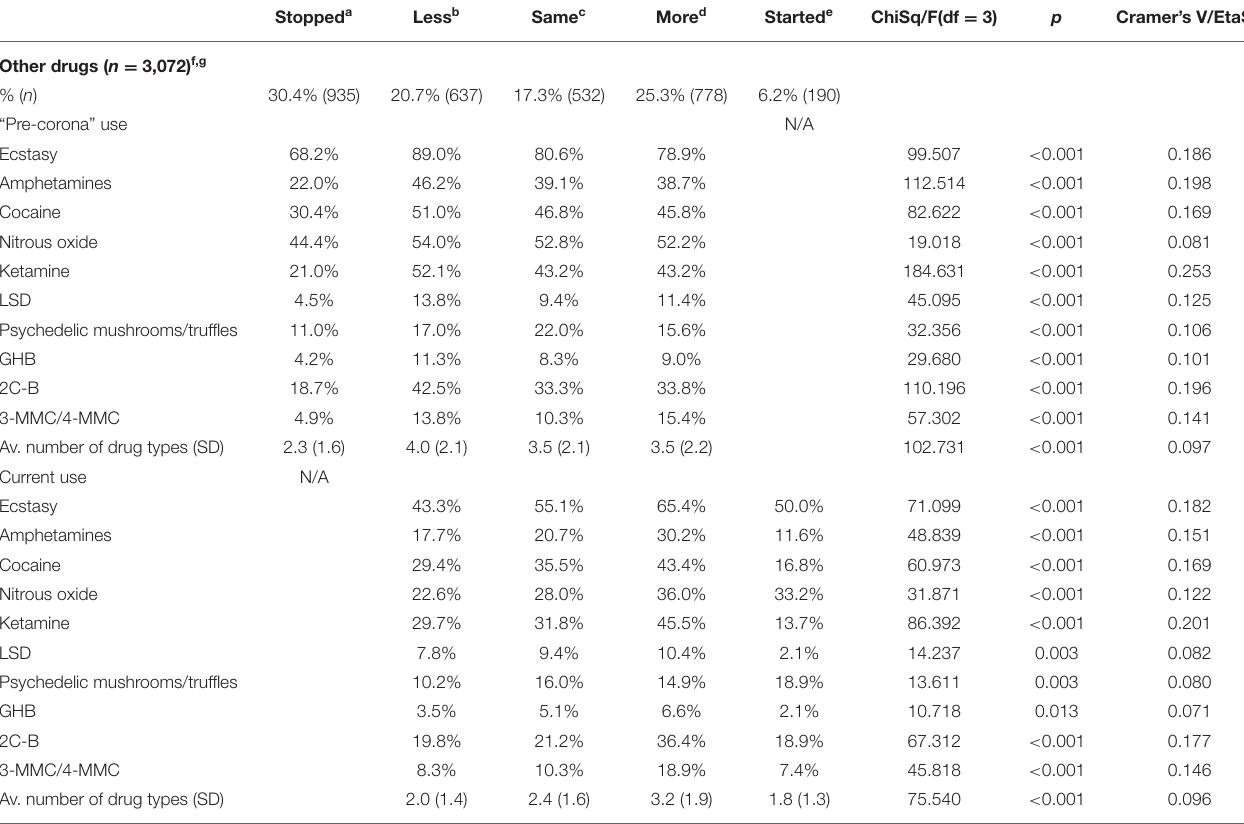
TABLE 3B | Change in the use of other drugs—current use compared to “pre-corona” use. Stopped a Less b Same c More d Started